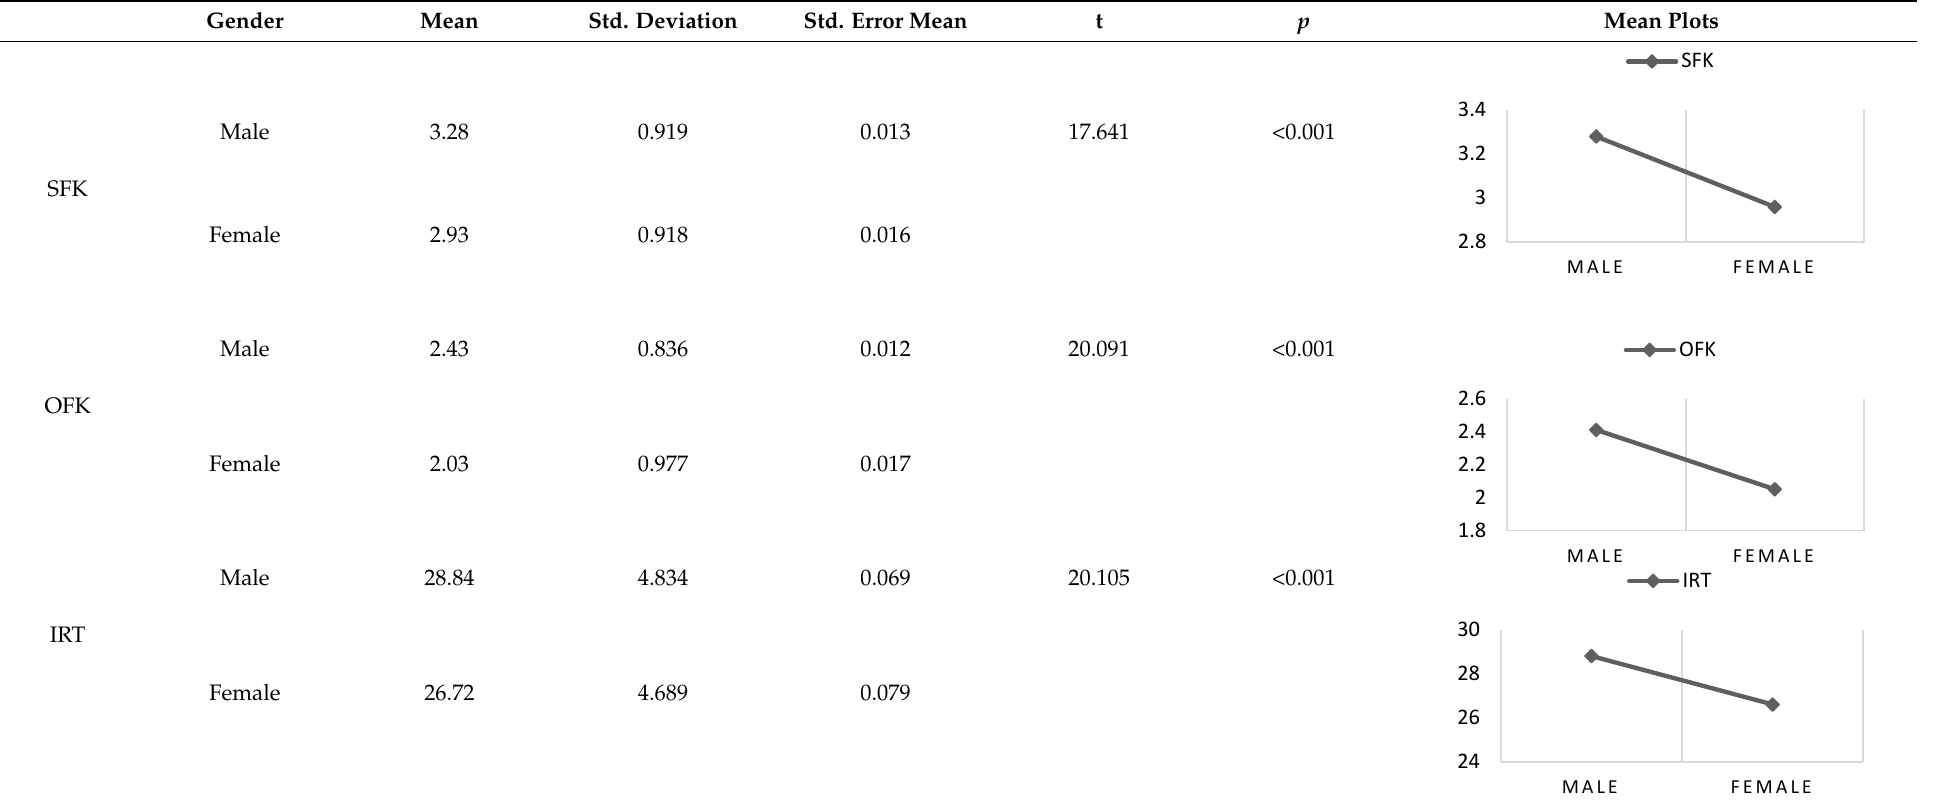
Table 3. Financial Knowledge and Investment Risk Tolerance Comparisons by Gender (N = 8038).